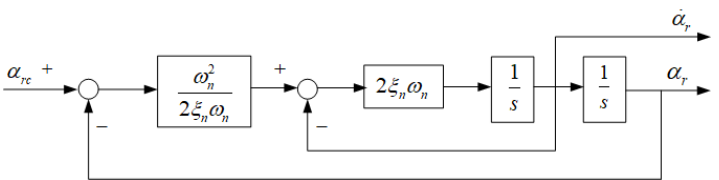
Figure 3. Configuration of the command